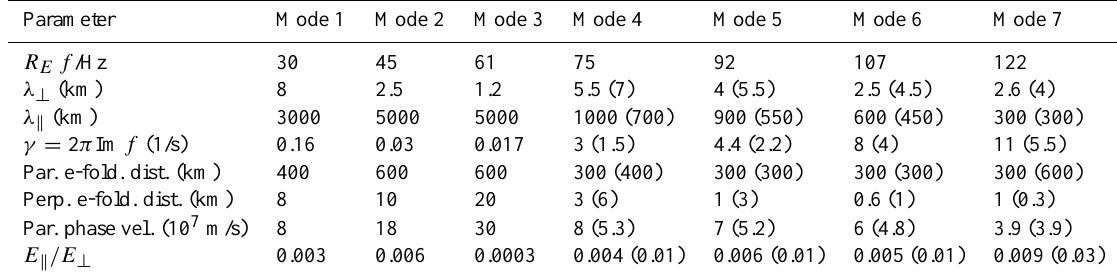
Table 1. Properties of Bernstein waves at region of maximum growth